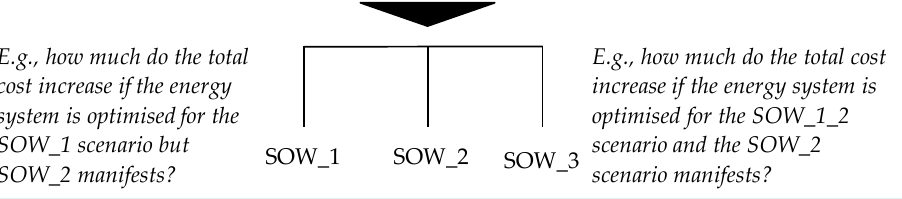
2 prices and energy carrier